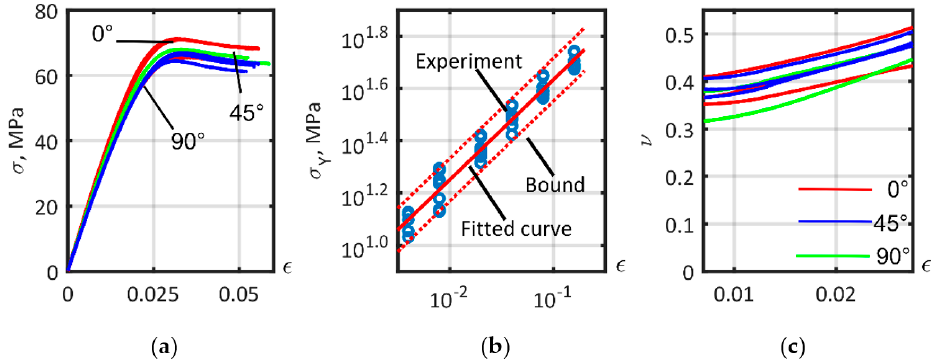
Figure 12. Tensile test of ISO 527 - 2 PA6 matrix samples: ( a ) Tension curves; ( b ) Yield stress; ( c ) Poisson’s ratio. ( c ) Poisson’s